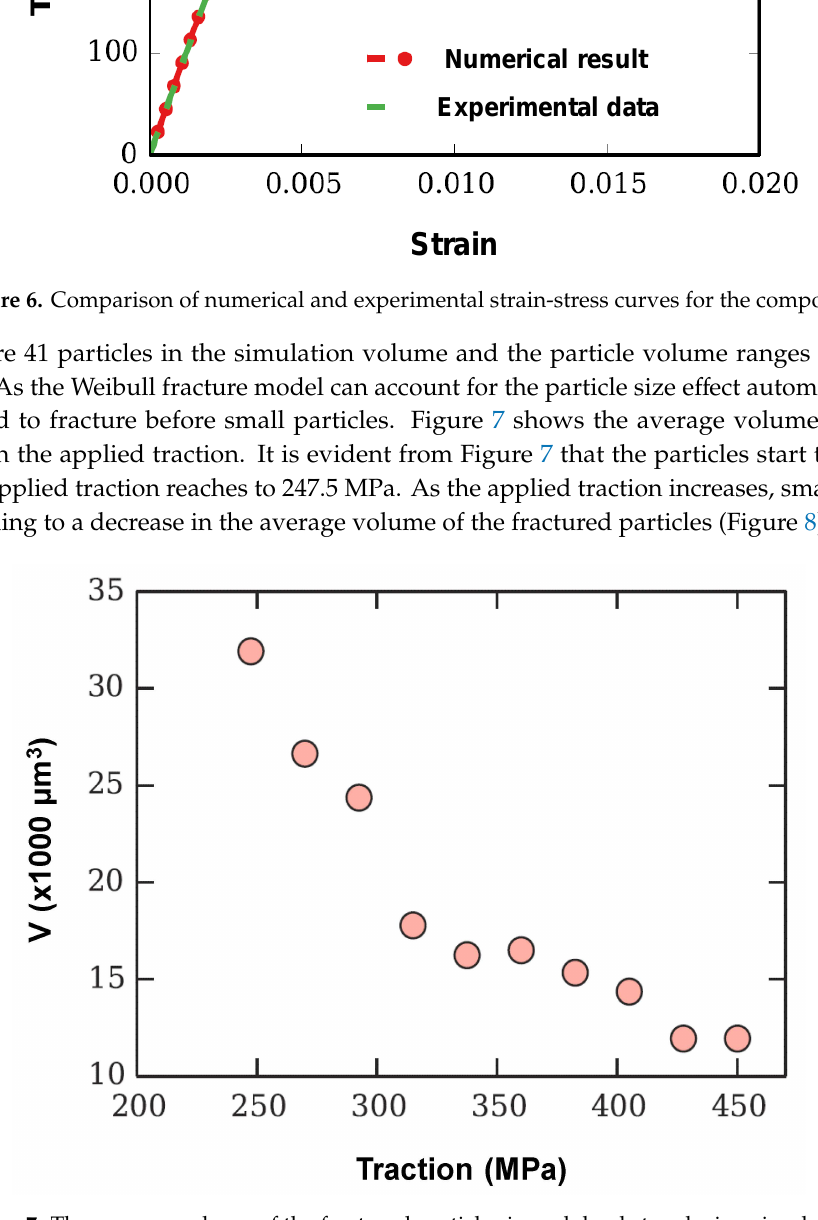
Figure 7. The average volume of the fractured particles in each load step during